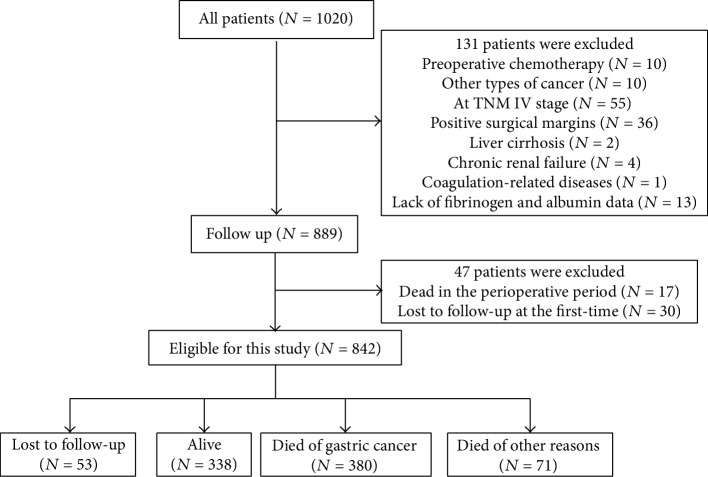
Flow of patients in the study.